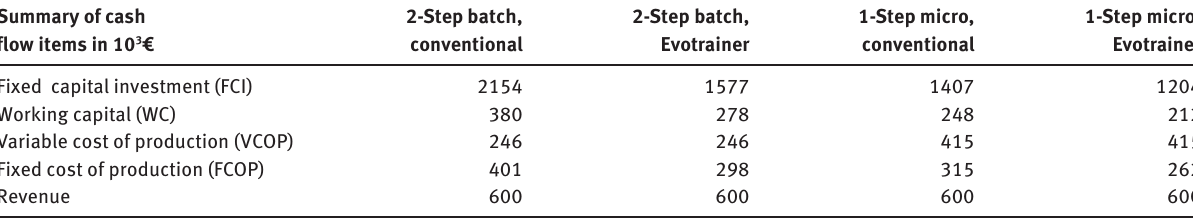
Table 8 Summary of cash flow items for the adipic acid